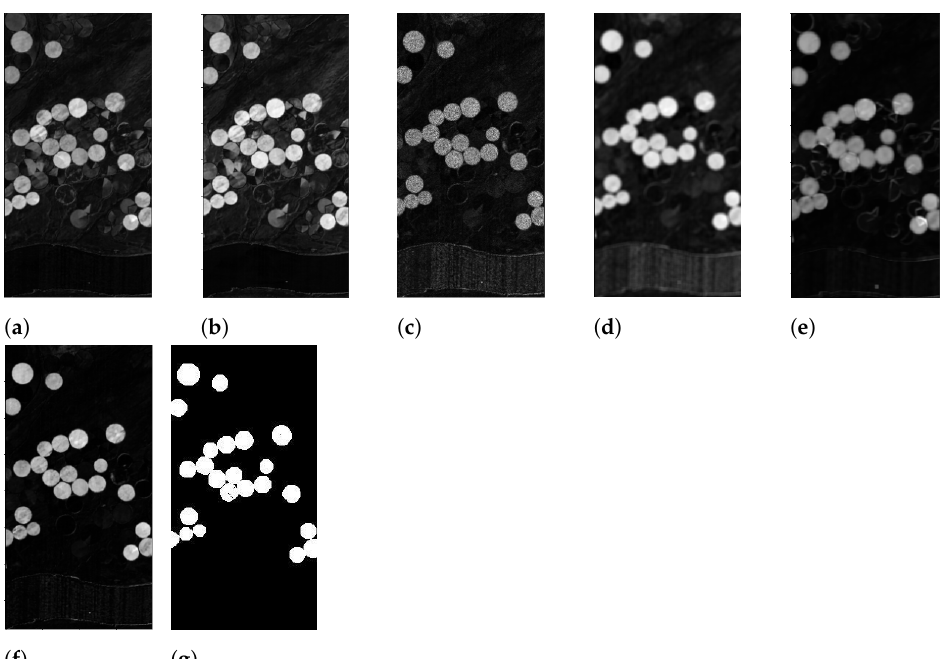
Figure 5. Results after line 2 in Algorithm 1 for the Hermiston dataset. ( a ) f 1 : Euclidean distance, ( b ) f 2 : Manhattan distance, ( c ) f 3 : SAM-ZID, ( d ) f 4 : SAM-MEAN, ( e ) f 5 : SMSADM, ( f ) f 6 : Pearson cc, ( g ) ground